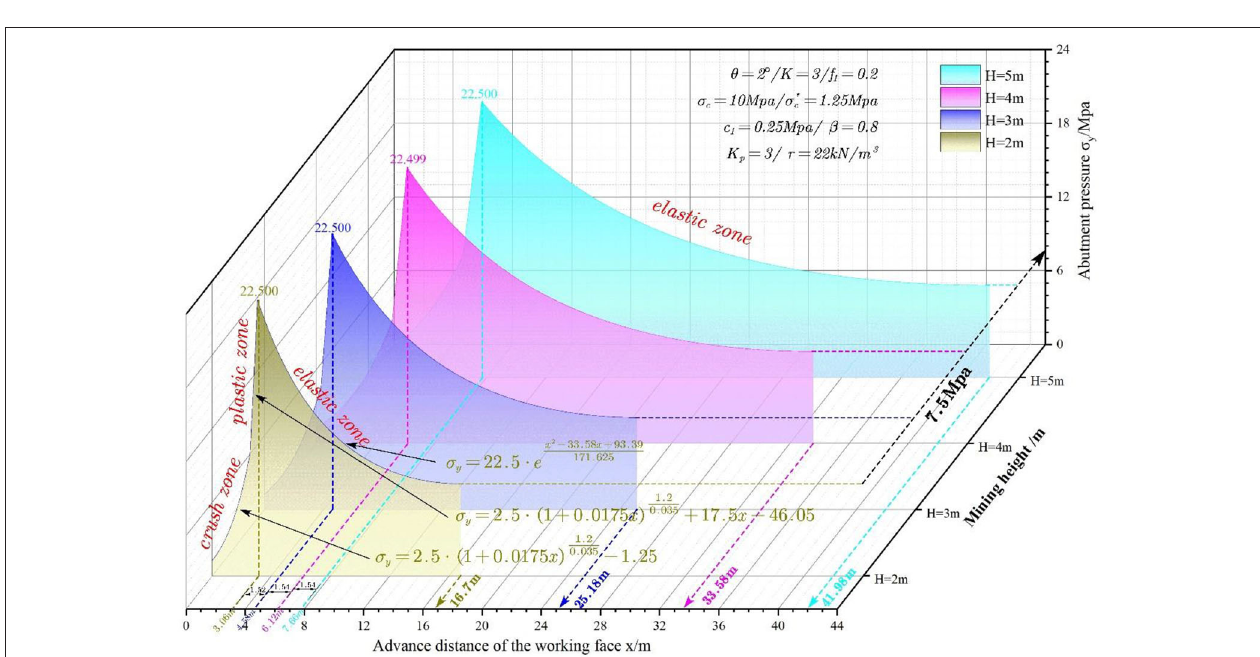
FIGURE 10 | Impacts of mining height on abutment pressure.